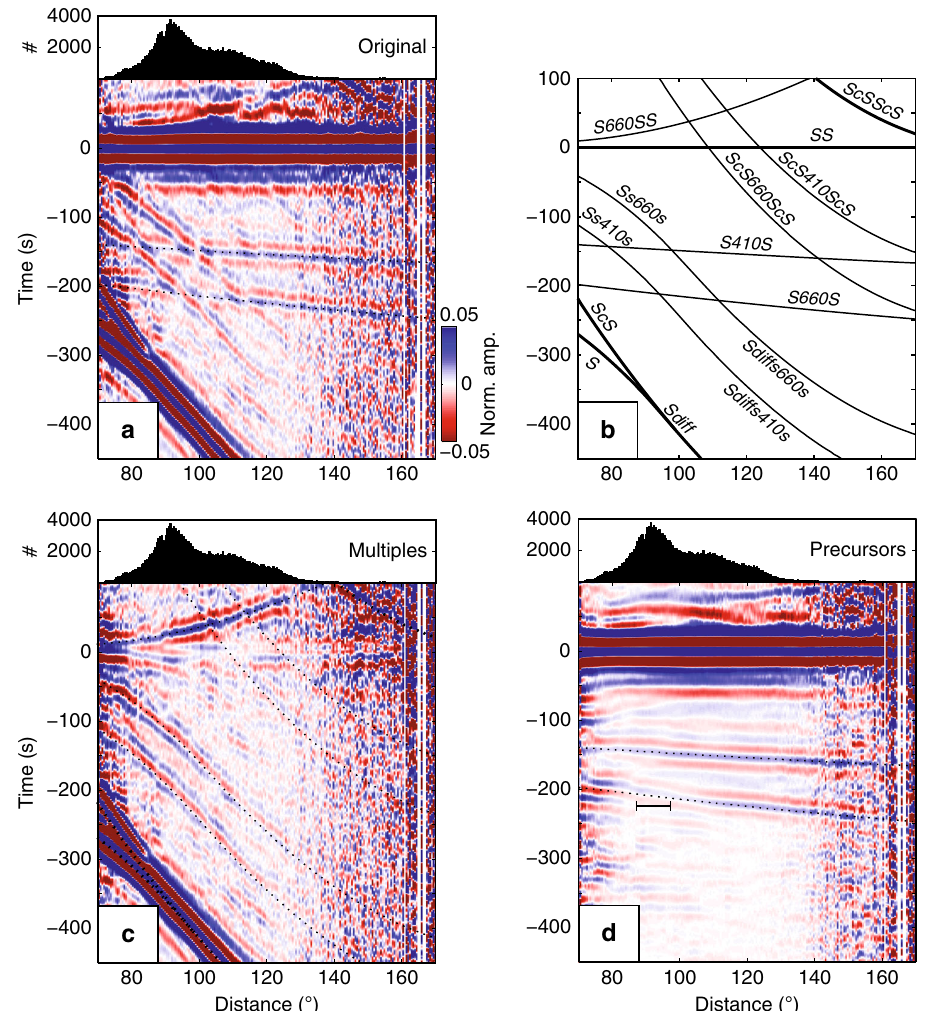
Fig. 2 SS precursors before and after array analysis. a Time – distance plot of ~180,000 waveforms between 70° and 170° stacked at 0.5° intervals and aligned on the surface re fl ection SS (set to 0 s). At large distances the stacks are noisy due to decreased data volume. b Travel times relative to SS predicted from ak135 26 . c Multiples of S , S diffractions, and precursors to ScSScS . d SS and precursors. Curvelet fi ltering effectively decomposes the recorded wave fi eld ( a ) into multiples ( c ) and the SS wave fi eld ( d ). Horizontal bar in d , near 200 s before SS , marks the distance across which the 660 re fl ection changes polarity (that is, 2 σ uncertainty of estimates of zero-re fl ection models (Supplementary Fig. 1) and calculation of S 660 S re fl ection coef fi cients ( R S660S ) in a two-layer medium (Supplementary